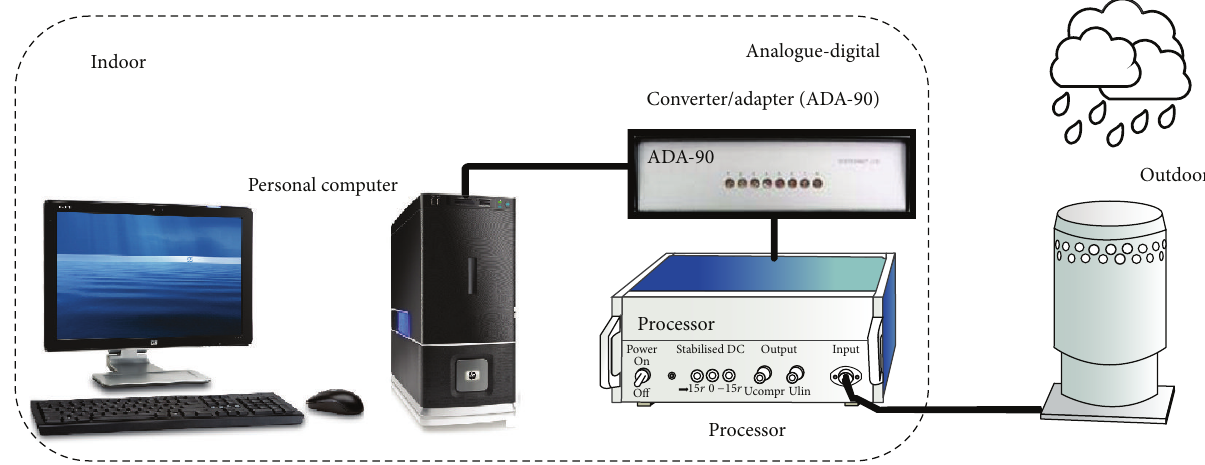
Figure 1: Measurement system for Joss-Waldvogel disdrometer (JWD, RD-69) installed at Universiti Teknologi Malaysia (UTM) campus in Kuala Lumpur, Malaysia.